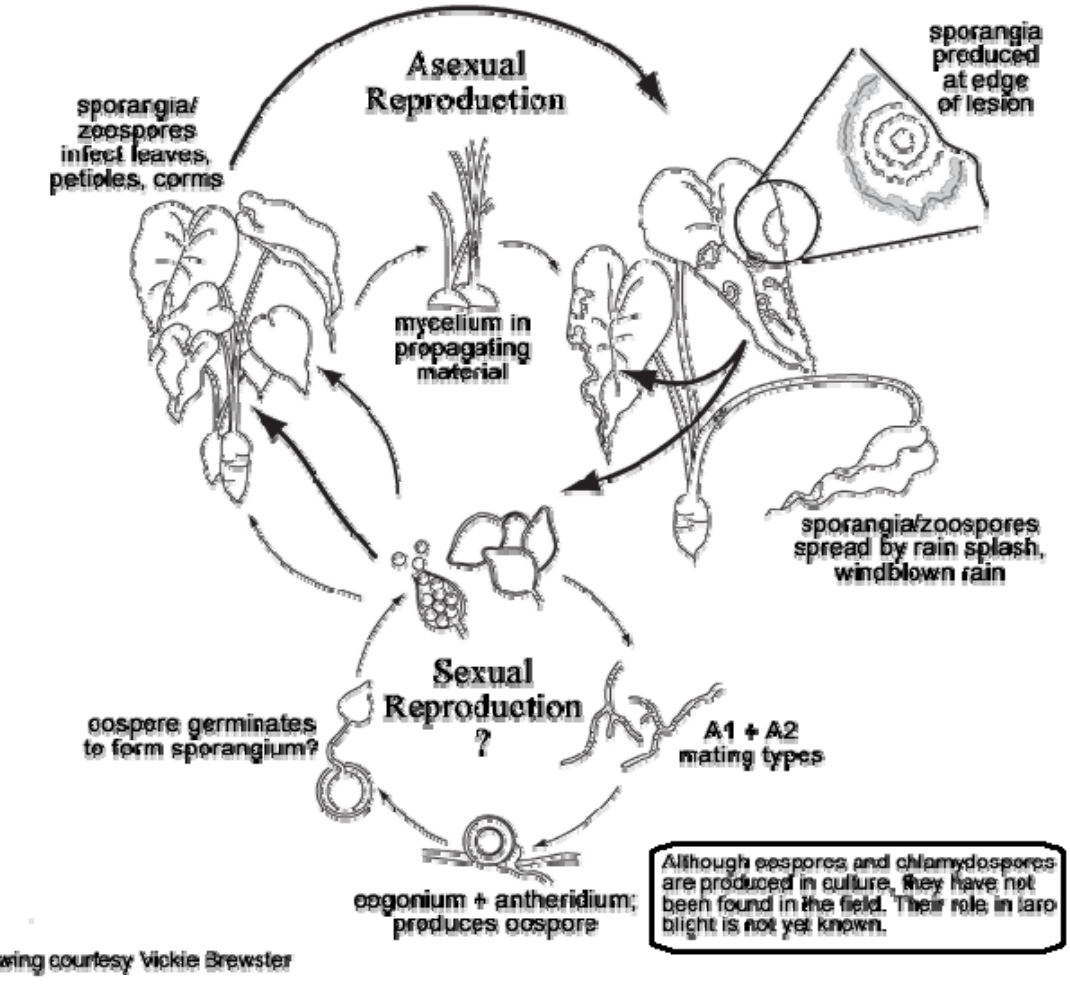
Figure 2. Taro leaf blight disease cycle and